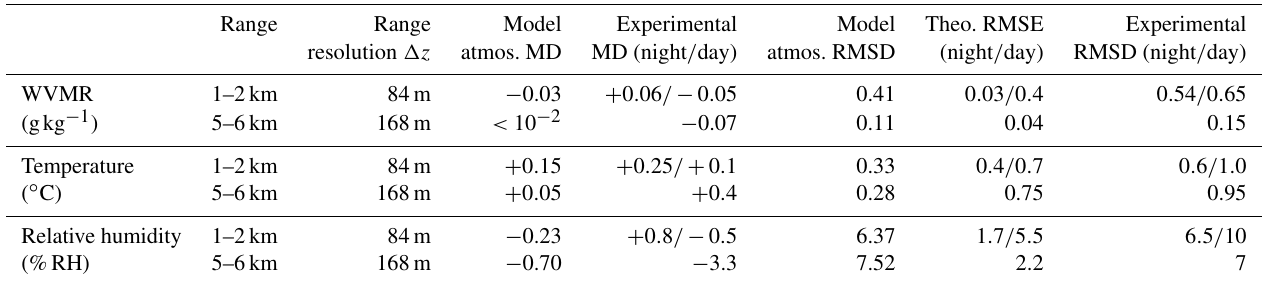
Table 4. Statistics of observed differences for r H , T , and RH: experimental mean differences (MD), root-mean-square differences 2 O (RMSDs), averaged over two different range bins, in the low troposphere (1–2km) and the free troposphere (5–6km). Comparison to the “natural” atmospheric variability between the lidar and RS sites as modeled by the ECMWF/IFS ERA5 reanalyses (difference over the considered period between grid points nearest to each of the two sites) and to the theoretical root-mean-square error (RMSE) derived from the variance of the RR signals. The grid points are located 8km WNW of the lidar and 2km S of the RS launching station 18.3km apart, and almost all RS trajectories below 6km altitude are contained within the same “pixel” of the ERA5 fields as the RS station. Range Range Model Experimental Model Theo. RMSE Experimental resolution (cid:49)z atmos. MD atmos.